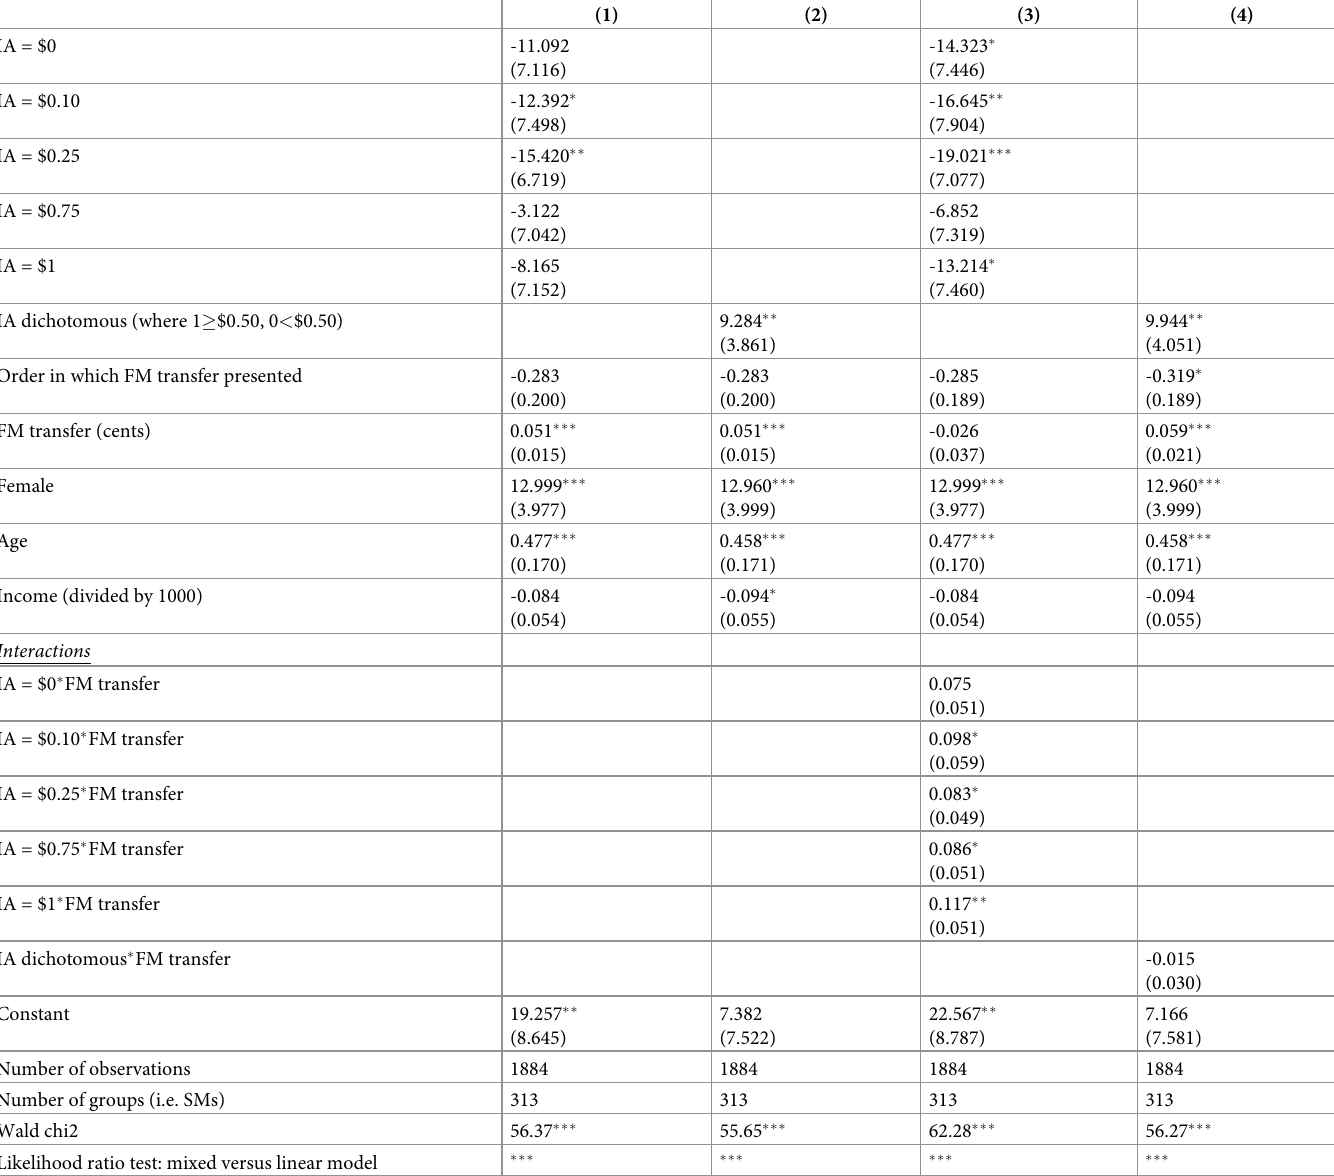
Table 3. Regressions on second mover transfers. The dependent variable is cents transferred per second mover to the recipients. The reference initial amount (IA) level is